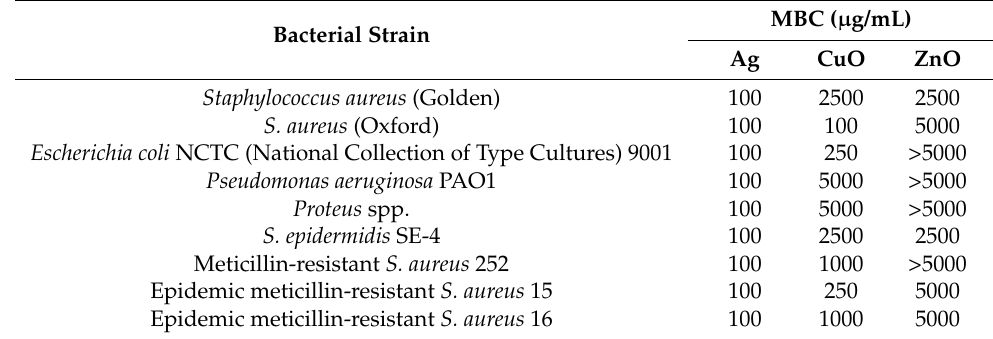
Table 3. MBCs (minimum bactericidal concentrations) of some inorganic NPs (nanoparticles) [48]. MBC ( µ g/mL) Bacterial Strain Ag CuO ZnO Staphylococcus aureus (Golden) 100 2500 2500 S. aureus (Oxford) 100 100 5000 Escherichia coli NCTC (National Collection of Type Cultures) 9001 100 250 >5000 Pseudomonas aeruginosa PAO1 100 5000 >5000 Proteus